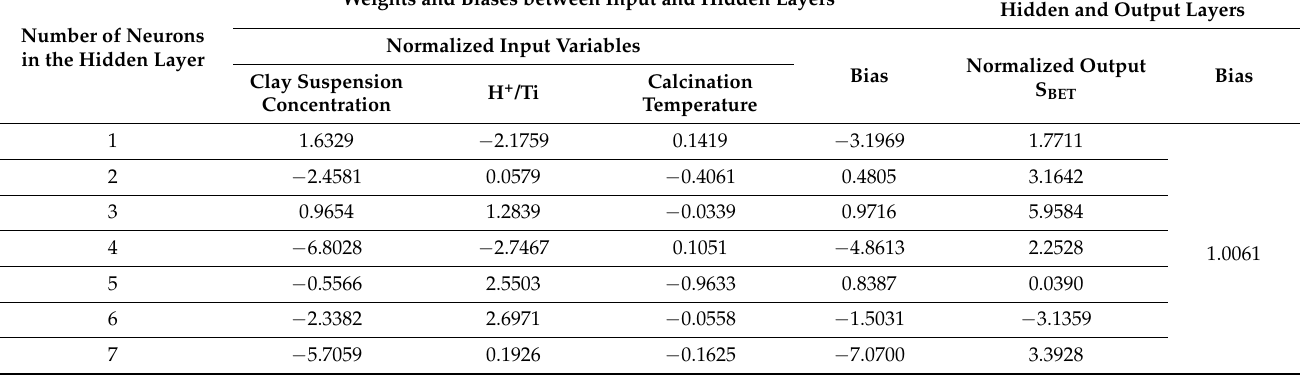
Figure 6. Comparison of all experimental results and ANN model predicted values. Table 2. Weight matrix of the designed